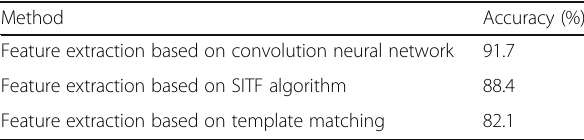
Table 1 Effect of different logo recognition